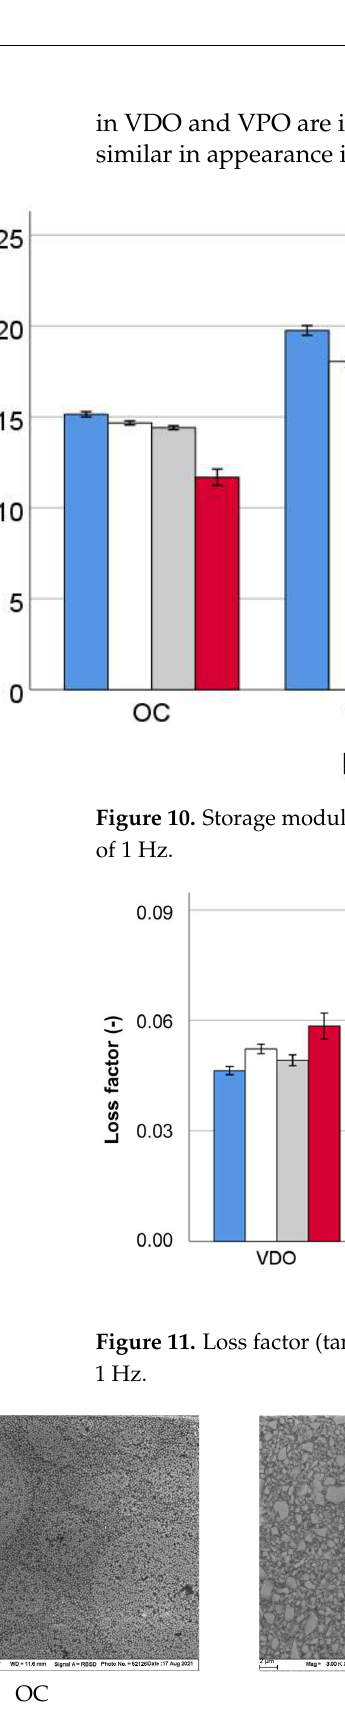
Figure 9. Indentation hardness (H IT ) as a function of frequency and aging method, exemplified for the material OC.